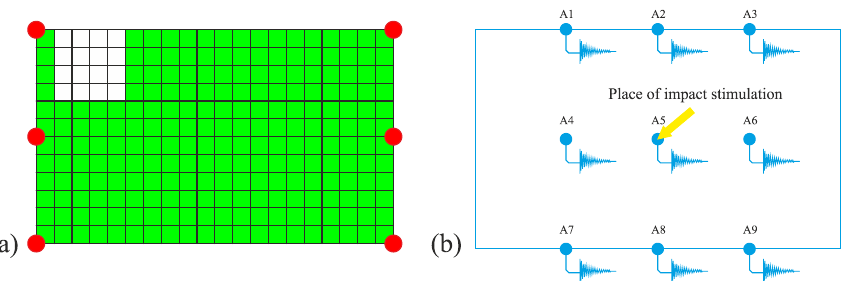
Fig. 3 View of the studied concrete slab (Ahmadnejad Zarnaghi and Tarighat 2018). a Meshed concrete slab with the position of hinge supports and damage scenario, b Location of accelerometers and position of impact load